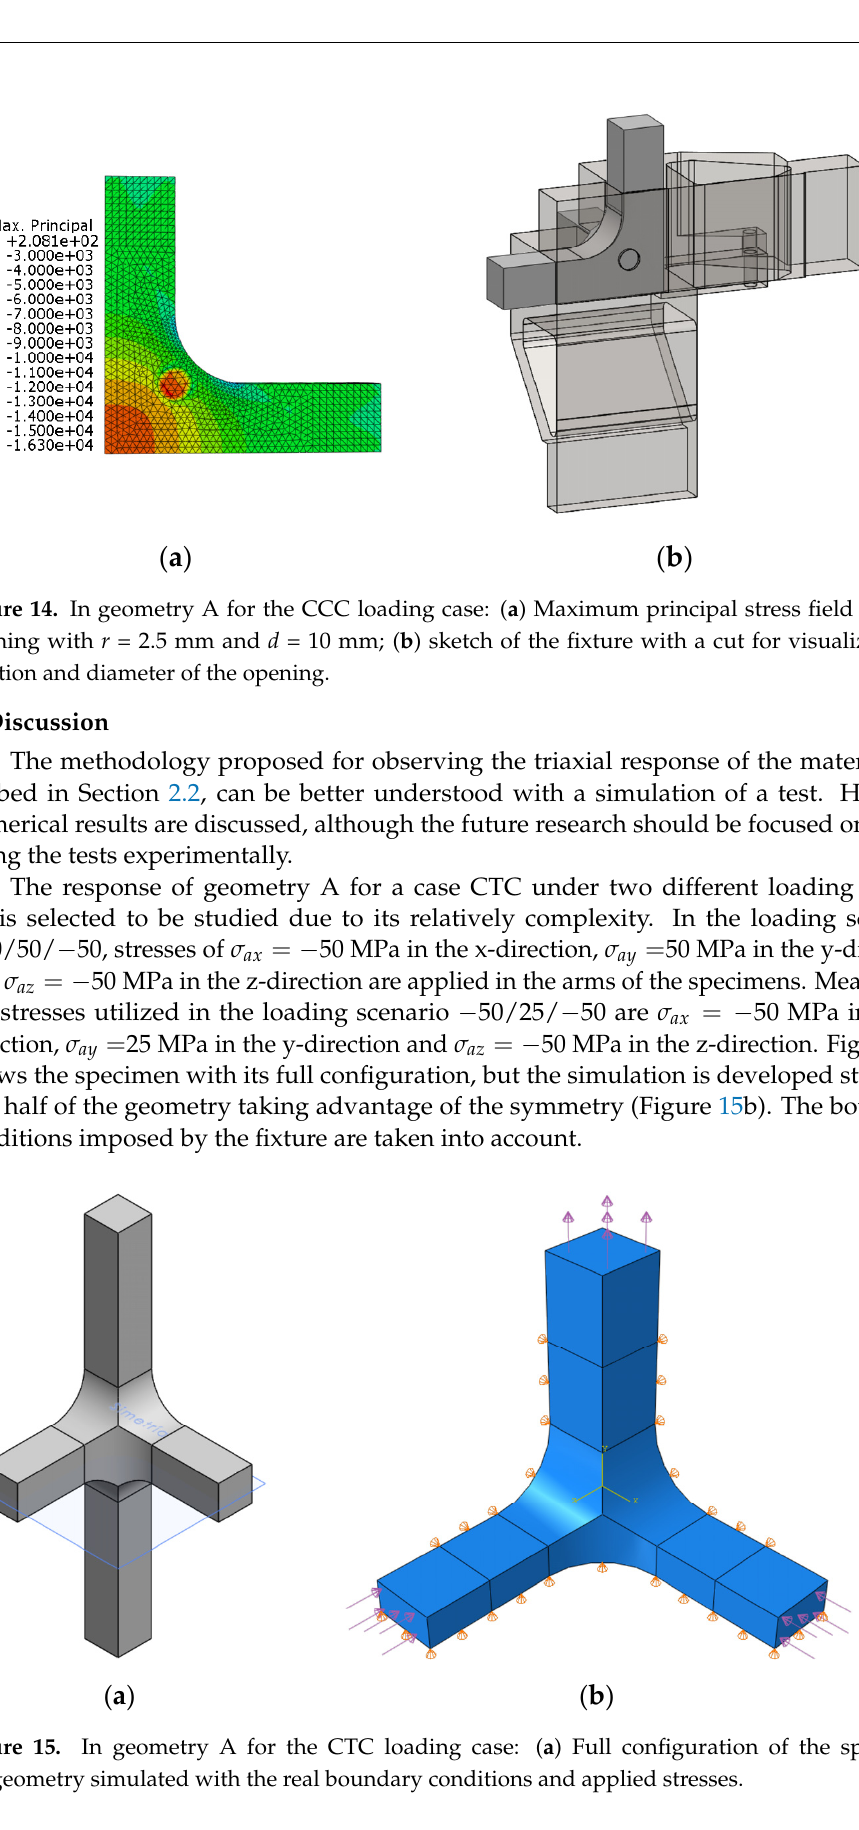
Figure 15. In geometry A for the CTC loading case: ( a ) Full configuration of the specimen; ( b ) ge- ometry simulated with the real boundary conditions and applied stresses.